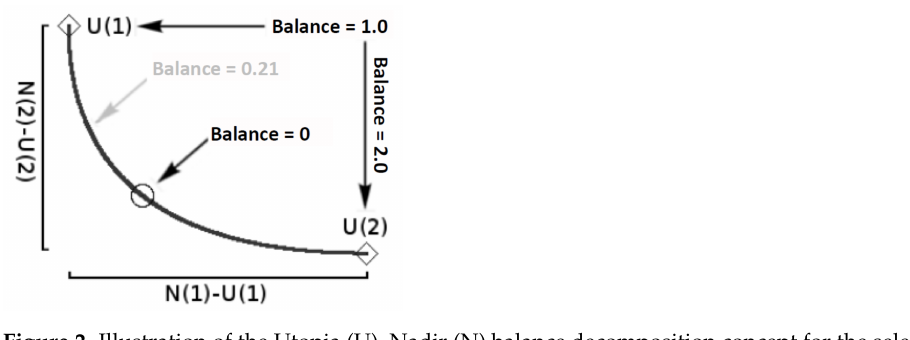
Figure 2. Illustration of the Utopia (U)–Nadir (N) balance decomposition concept for the selection of a trade-off solution in multi-objective optimization (MOO) (modified after [56]). The applied balance value of 0 indicates equal importance of both objectives.